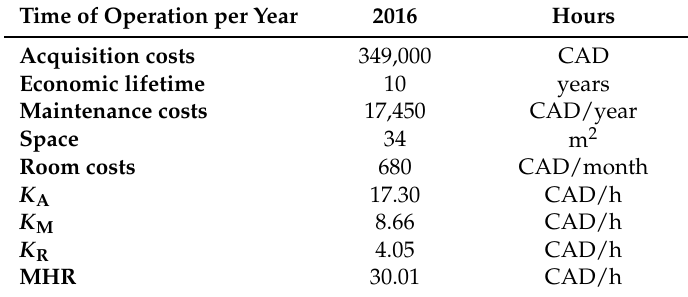
Table 2. Example of a calculation of the MHR for the four-axis filament winding system.